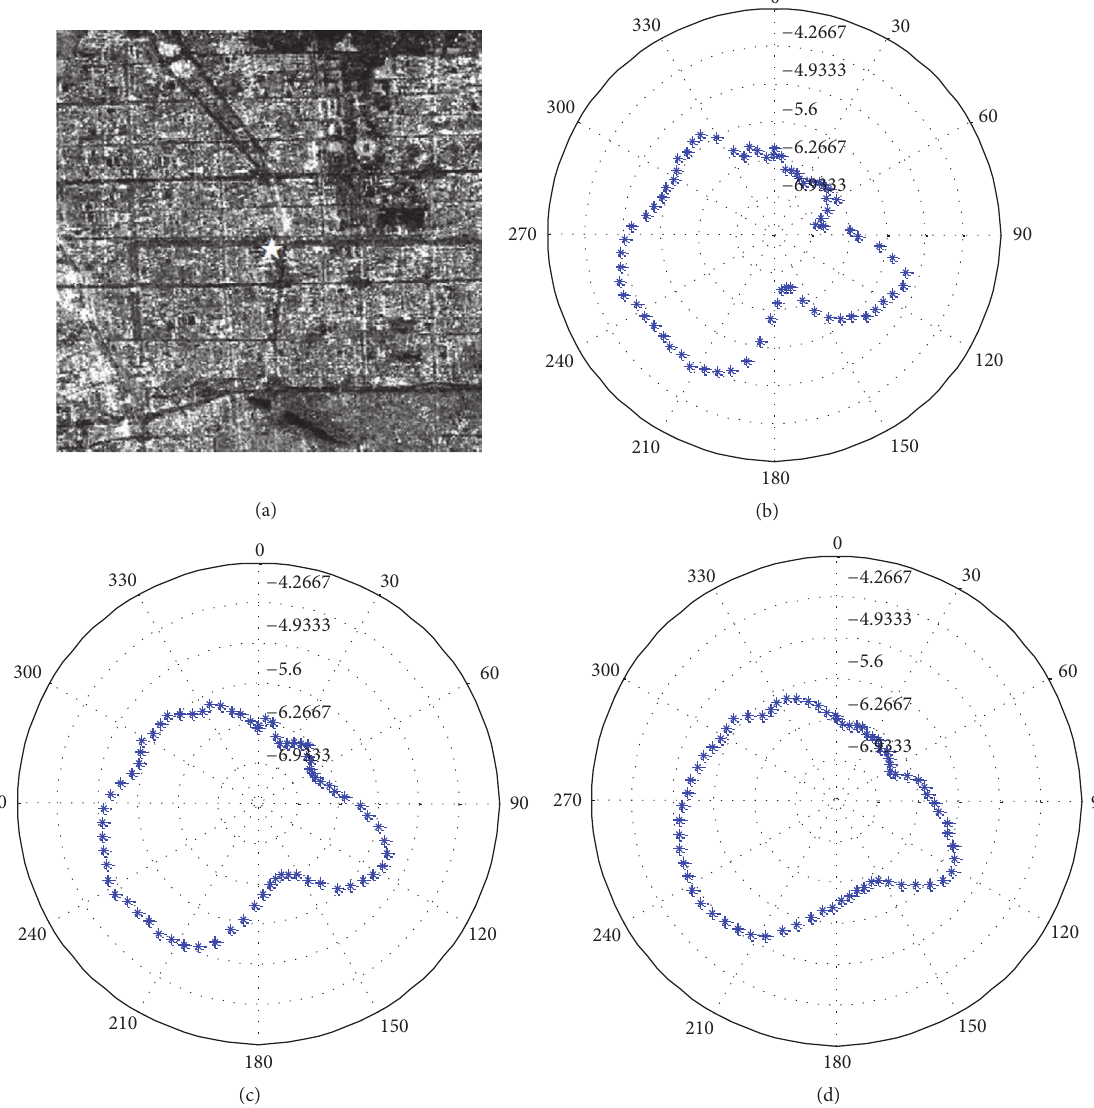
Figure 5: The backscattering coefficient extracted from various upwind sectors for the Beijing meteorological tower. (a) is the ALOS PALSAR image on 21 June 2007, and (b)–(d) show the backscattering coefficient within the predefined upwind sector with a radius of 4500 m, opening angles of 30 ∘ , 45 ∘ , and 60 ∘ ,